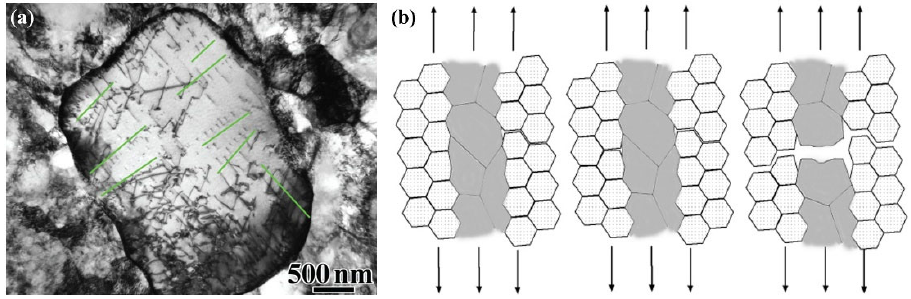
Figure 2. ( a ) A coarse grain surrounded by ultrafine ‐ grained matrix in a bimodal structured Ti (dislocations pile ‐ ups are marked by green lines) [51]; ( b ) the model of crack propagation in the bimodal structure (the arrows represent the directions of stress) [40].